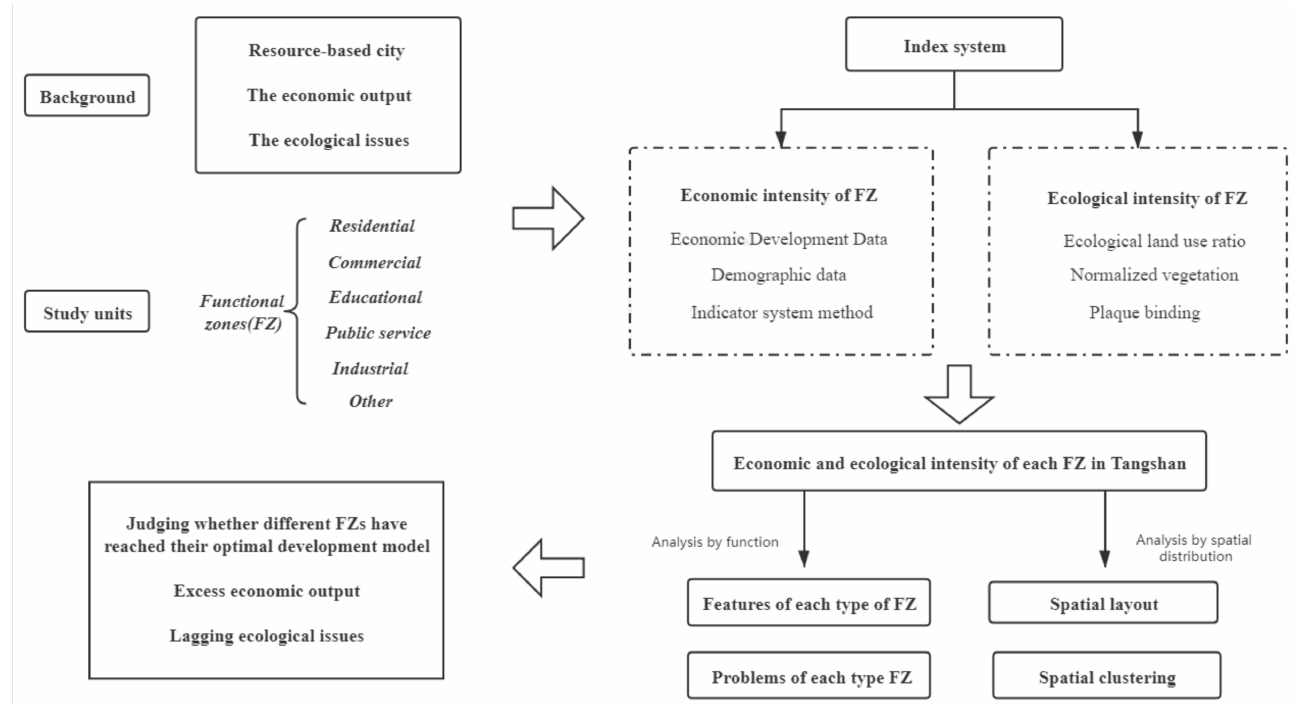
Figure 2. Research